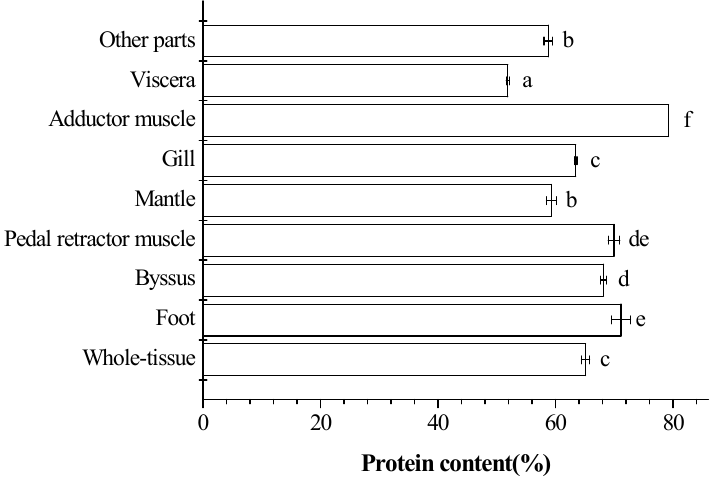
Figure 1. Eight different parts of Mytilus edulis tissues, i.e., foot, byssus, pedal retractor muscle, mantle, gill, adductor muscle, viscera, and other parts, from Mytilus edulis were separated and prepared. The protein content of different tissues was measured by the Kjeldahl method. Values are mean ± SD ( n = 3–6). Different letters beside the bars represent a significant difference between the values.